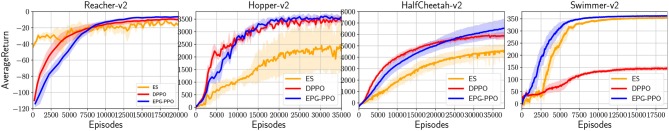
Depict the average cumulative rewards of the policy after the crossover in EPG-PPO, the distributed policies in DPPO and the updated policy in ES, plotted over the episodes required during training. The solid lines represent the average performance in six repeated experiments with different random seeds and the shades exhibit the standard deviation of the performance in those repeated experiments.